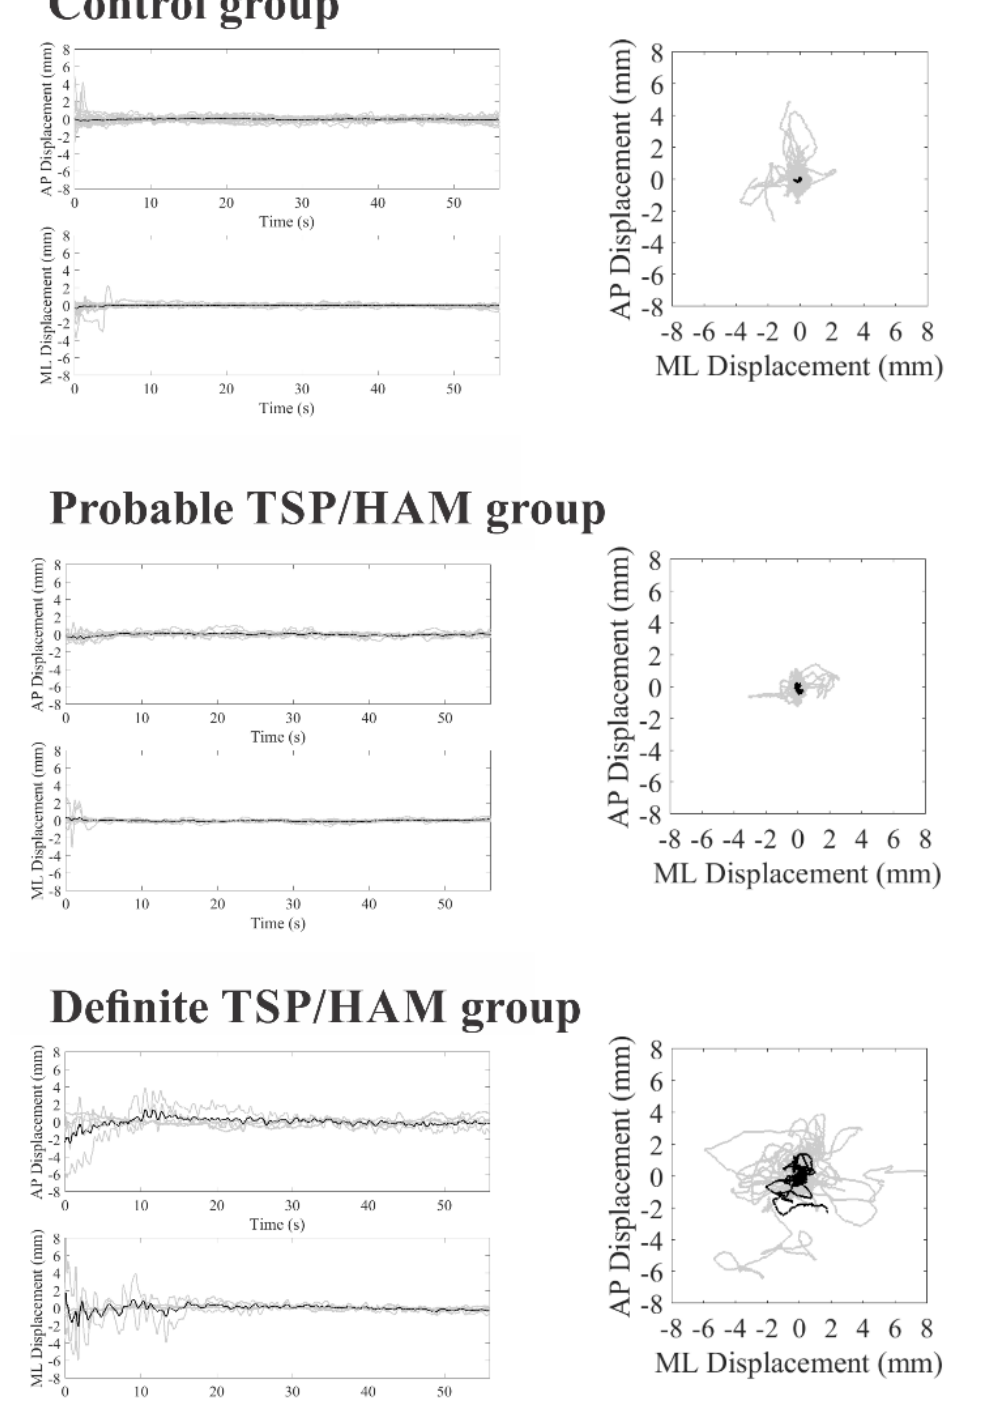
Figure 1. COP displacements in the anteroposterior (AP) and mediolateral (ML) axis as a function of the duration of the test (on left) and statokinesiograms (on right) of the control group, probable TSP/HAM group, and definite TSP/HAM group under the open-eye condition. Gray recordings represent individual waveforms; black recordings represent the grand average recordings.